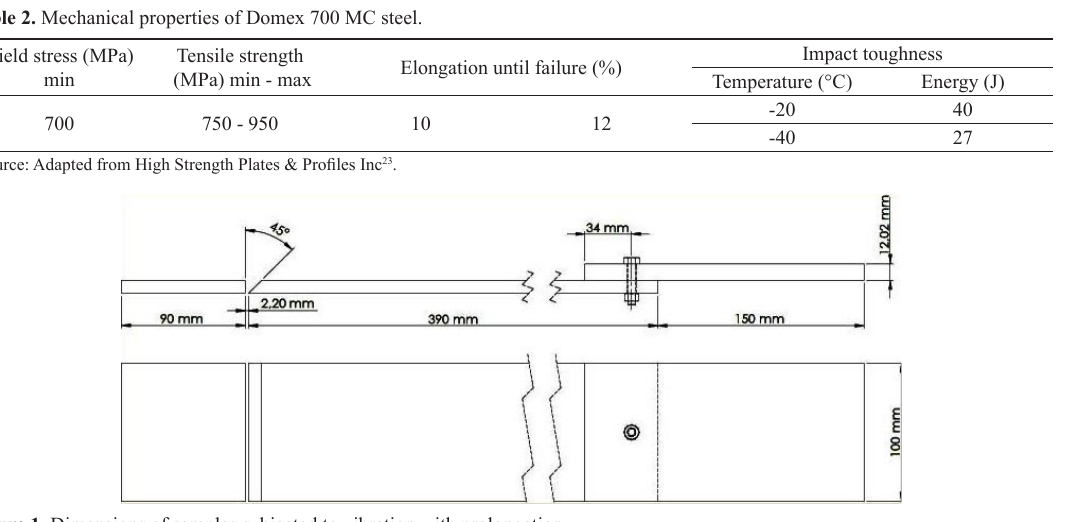
Figure 1. Dimensions of samples subjected to vibration with